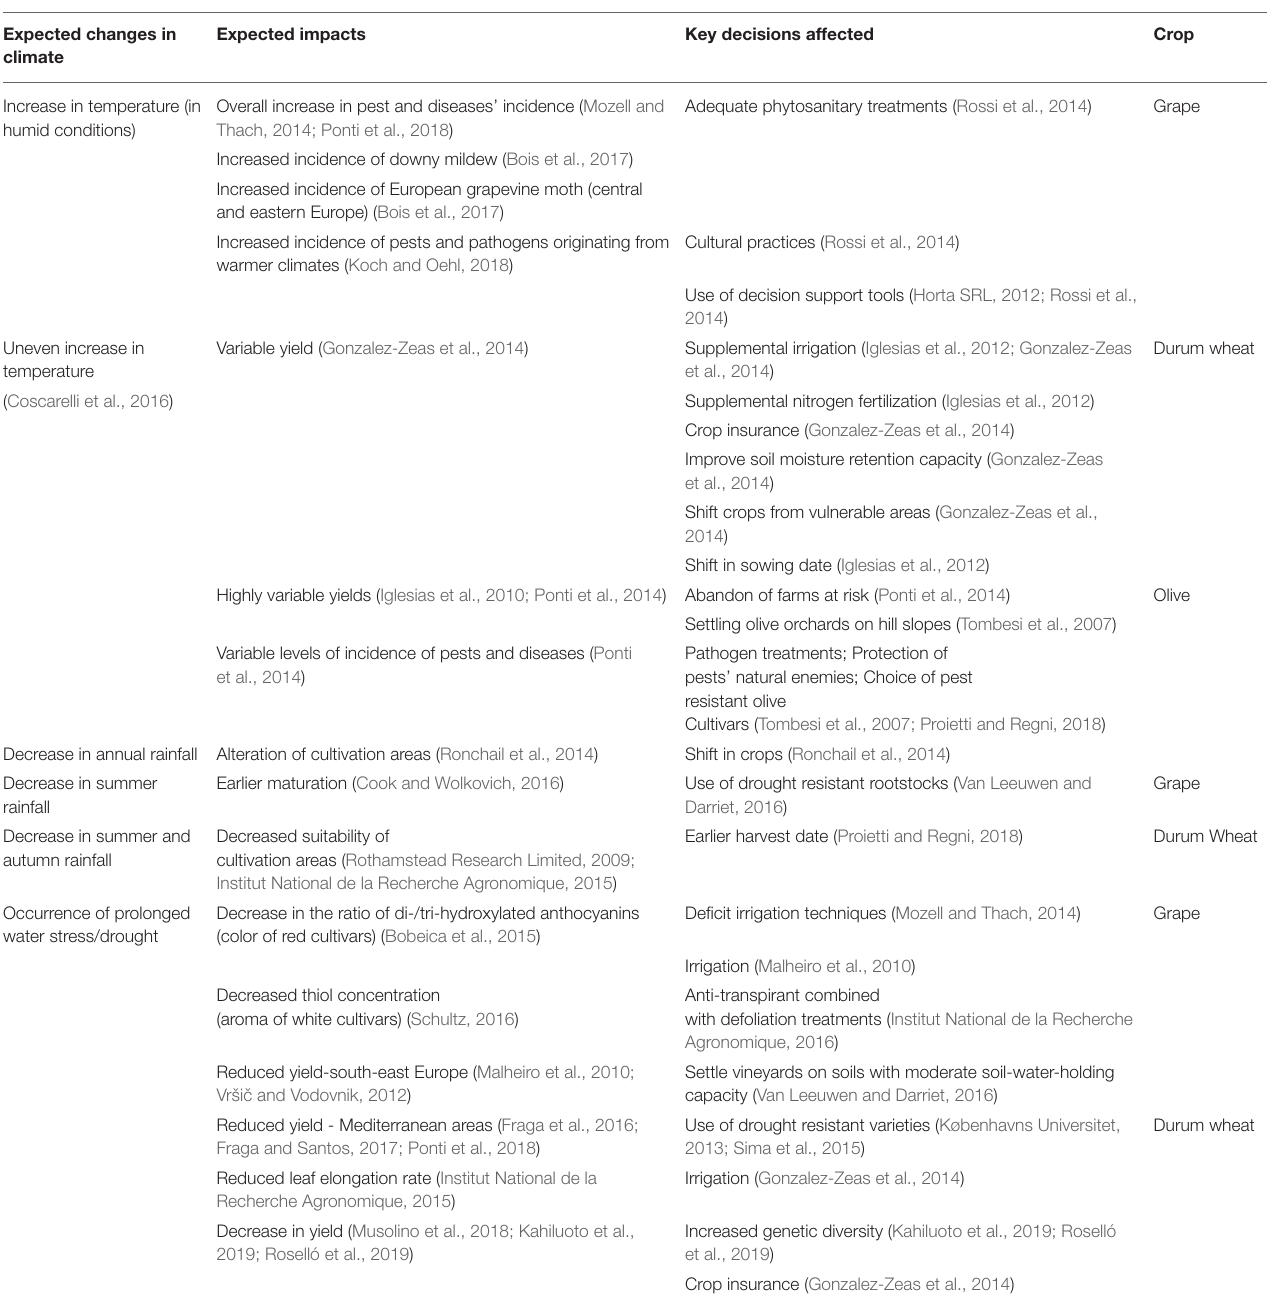
TABLE 2 | Expected changes in climate, its impacts, and key decisions affecting olive, grape, and durum wheat